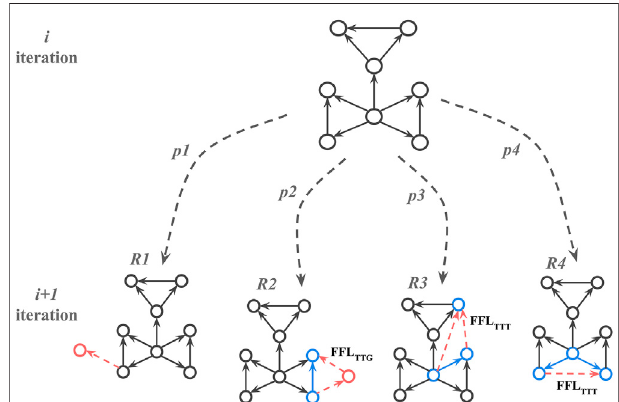
FIGURE 4 | Attachment rules that create FFL motif enriched network; p1 , p2 , p3 , and p4 correspond to probabilities for choosing rule R at the next iteration while growing network. FFL TTG and FFL TTT correspond to different FFL motif types, where G or T (Gene or Transcription factor) indicate whether a participating node has only incoming edges (G), or at least one outgoing edge (T). The red dotted arrows here show new edges added to the network and the solid blue arrows show edges participating in the new FFL motif with the new